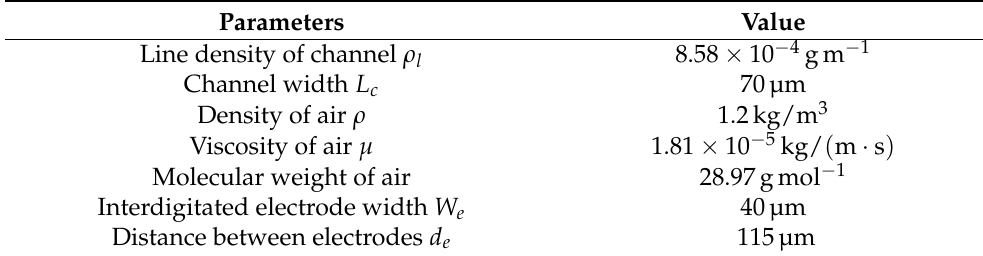
Table 2. Value of parameters involved in simulations and